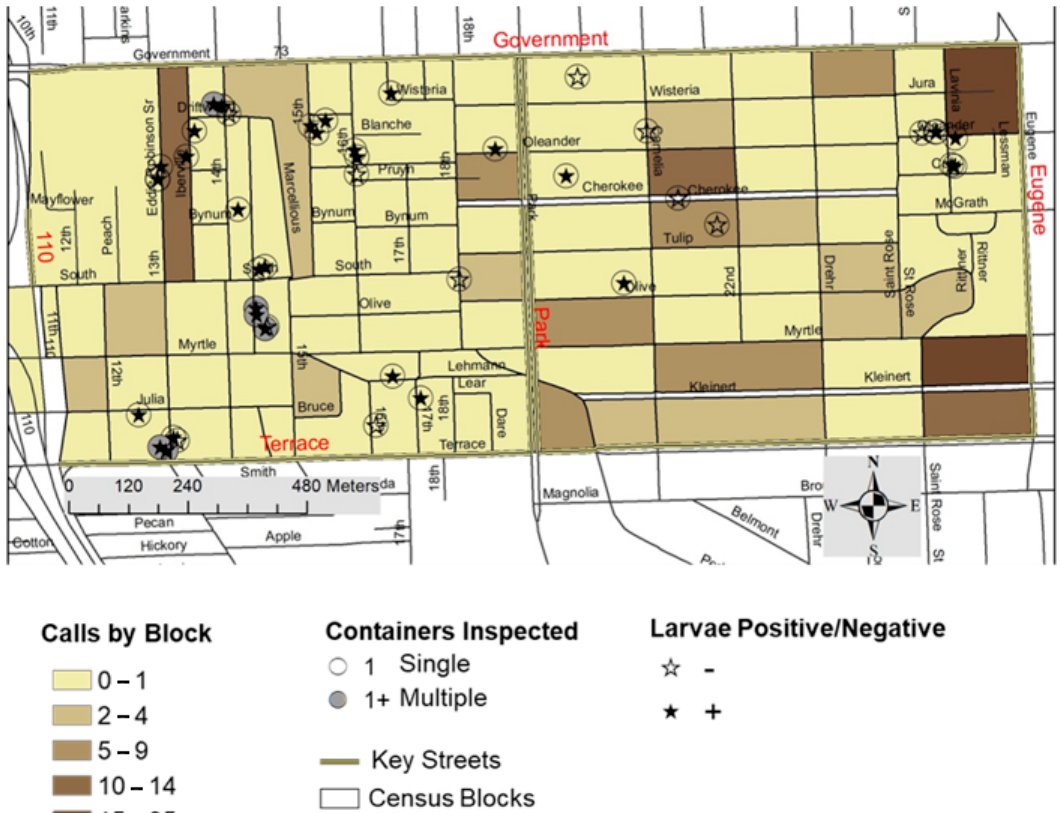
Figure 2. Service request calls and results from larvae survey showing locations with larvae positive and larvae negative containers, as well as locations of inspected containers, indicating places with more than one container (1+). All of the multiple (1+) containers were discarded tires.